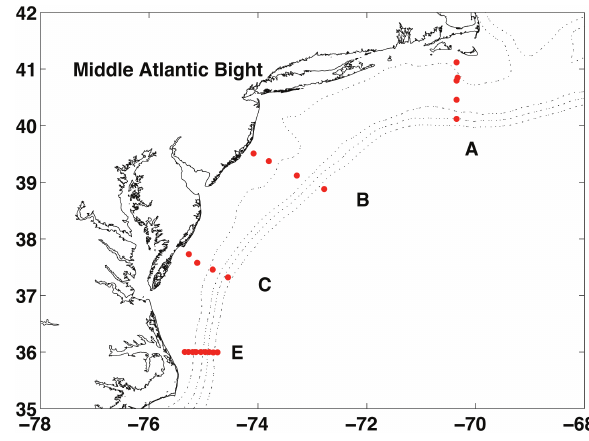
Fig. 3. Nitrate plotted over phosphate for 25790 samples from the MAB shelf. Samples were taken during cruises undertaken by Brookhaven National Laboratories and during the SEEP and OMP programs (see text for details). N*, given in color, quantifies the ni- trogen excess/deficit with respect to phosphate. The bold line marks N* = 0 and corresponds to the Redfield ratio of 16:1.